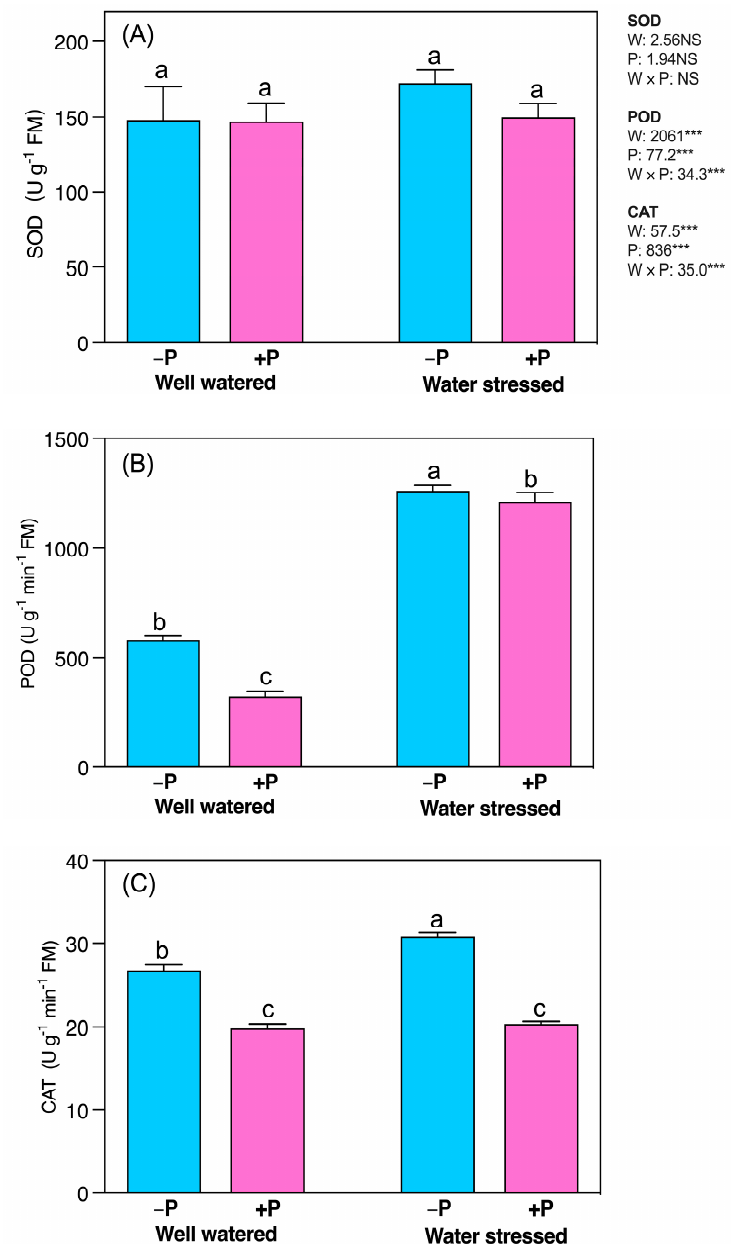
Figure 6. Changes in the activity of ( A ) SOD, ( B ) POD, and ( C ) CAT in response to P supplementation, under well-watered and drought-stressed conditions. A different letter following the means indicates significant differences ( p < 0.05) between the four treatments, as determined by Duncan’s test. Bars represent means ± SD. An overview of the two-way ANOVA assessing the effect of water (W) and phosphorus (P) treatments is presented in the right-hand corner of each panel. * and *** indicate that F values were significant at p ≤ 0.05, 0.01, and 0.001, respectively.